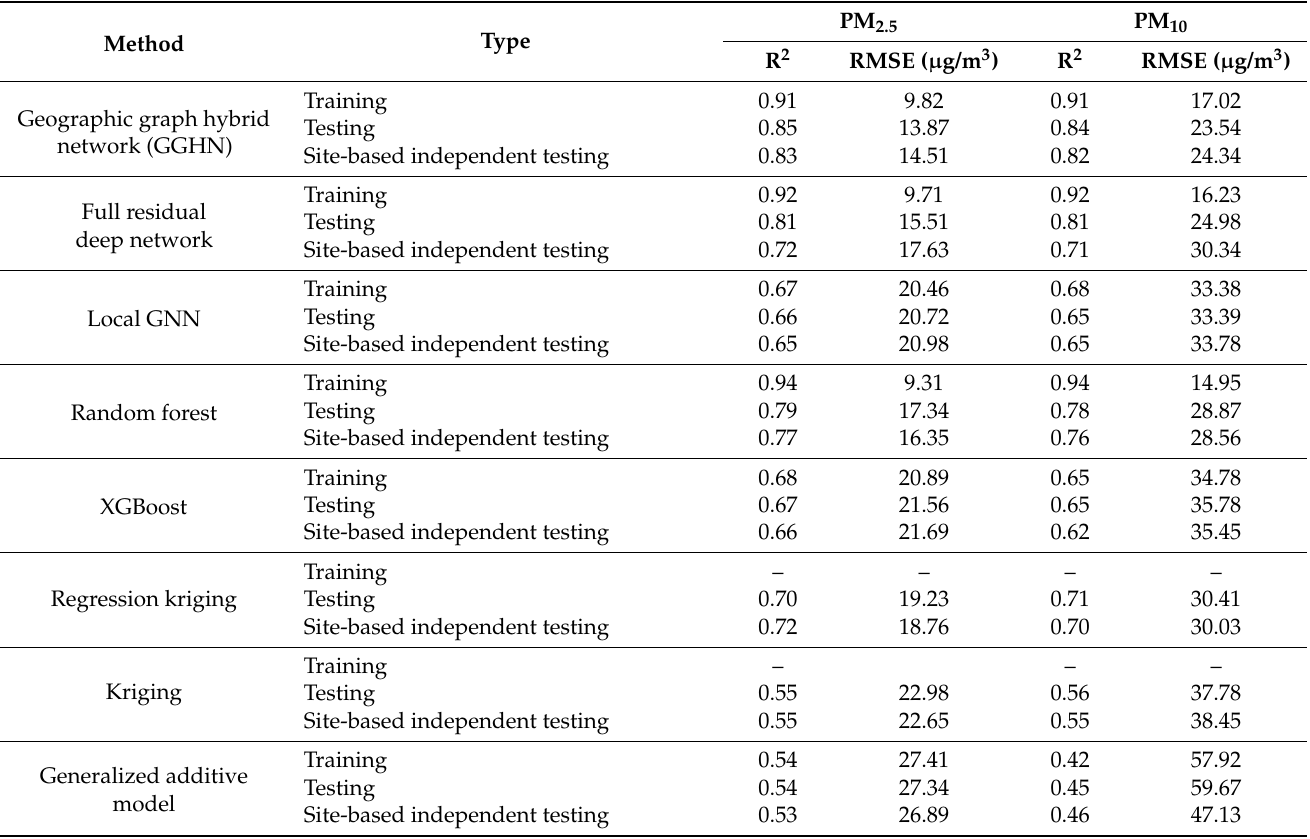
Table 2. Training, testing and site-based independent testing for PM 2.5 and PM 10